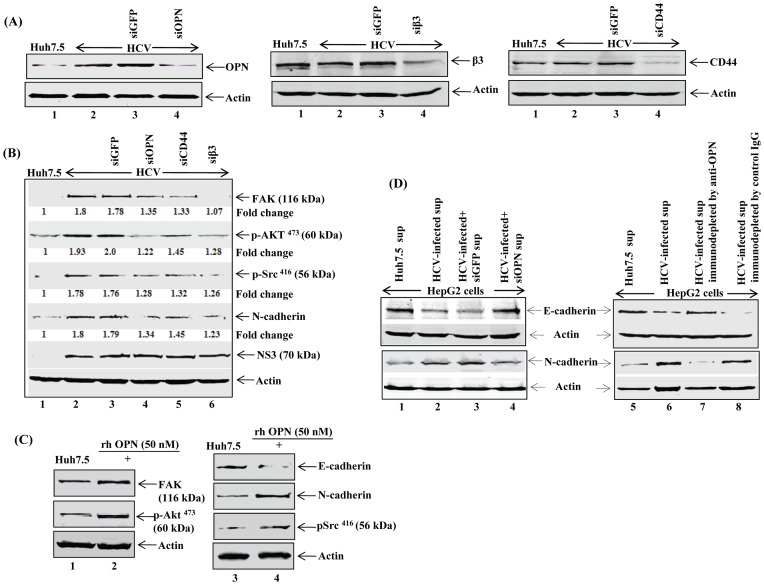

Role of HCV-induced OPN in cell signaling cascade.
(A) HCV-infected cells were transfected with siGFP, siOPN, siCD44, and
                            siβ3 as described in Materials and Methods. At 72 h
                            posttransfection, cells were harvested and equal amount of cellular
                            lysates were subjected to western blot analysis using anti-OPN,
                            anti-β3 and anti-CD44. (B) The above cellular lysates were
                            subjected to western blot analysis using anti-FAK, anti-p-Akt (Ser
                                473), anti-p-Src (Tyr 416), and
                            anti-N-cadherin antibodies. HCV NS3 was used as a representative of
                            HCV-infection. (C) Mock (Huh7.5) cells were treated with recombinant
                            human OPN (rhOPN) (50 nM) for 48 h. Cells were harvested and equal
                            amounts of cellular lysates were immunoblotted using anti-FAK and
                            anti-p-Akt (Ser473) (lane 1, 2), anti-E-cadherin,
                            anti-N-cadherin, anti-pSrc 416 (lane 3, 4). (D) Cellular
                            lysates from HepG2 cells incubated with cell culture supernatants from
                            mock, HCV-infected cells and those infected cells transfected with siOPN
                            and siGFP were immunoblotted using anti-E-cadherin and anti-N-cadherin
                            (lane 1–4). Similarly cellular lysates from HepG2 cells
                            incubated with cell culture supernatants from mock and HCV-infected
                            cells with/without immunodepletion by anti-OPN, were immunoblotted using
                            anti-E-cadherin and anti-N-cadherin (lane 5–7). Immunodepletion
                            by isotype control goat IgG antibody was used as control (lane 8). Actin
                            was used as protein loading control. The results shown are the
                            representative of three independent experiments.